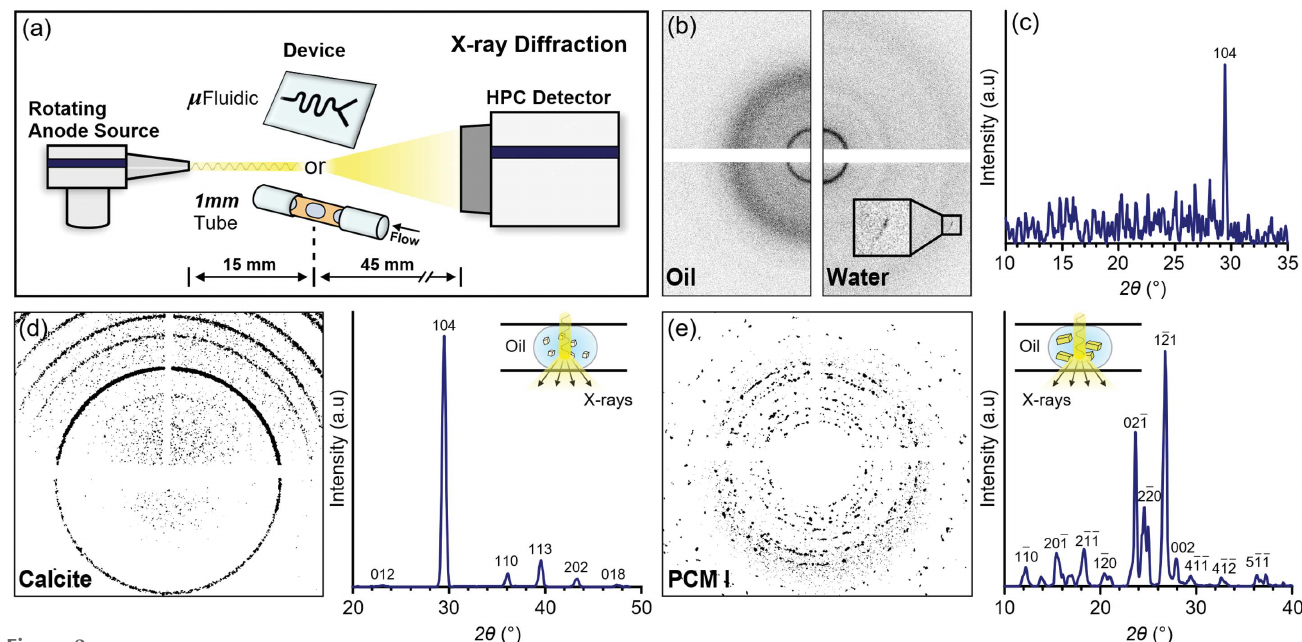
Figure 2 ( a ) Experimental setup on the XtaLAB Synergy-R single-crystal diffractometer illustrating both the microfluidic and the millifluidic devices that were utilized. ( b ) Representative 2D XRD patterns showing the characteristic scattering of water-in-oil droplets within the microfluidic device collected with 25 ms exposures. The zoomed-in inset shows a 104 reflection from calcite. ( c ) Integrated and background-subtracted 1D diffraction pattern of the right frame of ( b ) showing that the 104 reflection was preserved during data reduction. ( d ) Serial 2D (left) and 1D (right) diffraction patterns of calcite crystals obtained from automated background subtraction and combination of multi-frame diffraction data (90 s cumulative exposure time). The diffraction peaks are labelled with their corresponding reflections. ( e ) Serial 2D (left) and 1D (right) diffraction patterns of PCM I crystals obtained from automated background subtraction and combination of multi-frame diffraction data (90 s cumulative exposure time). The diffraction peaks are labelled with their corresponding reflections. The insets in ( d ) and ( e ) illustrate the path of the X-ray beam through the microchannel, where only diffraction frames corresponding to slurry plugs are integrated into the final serial diffraction